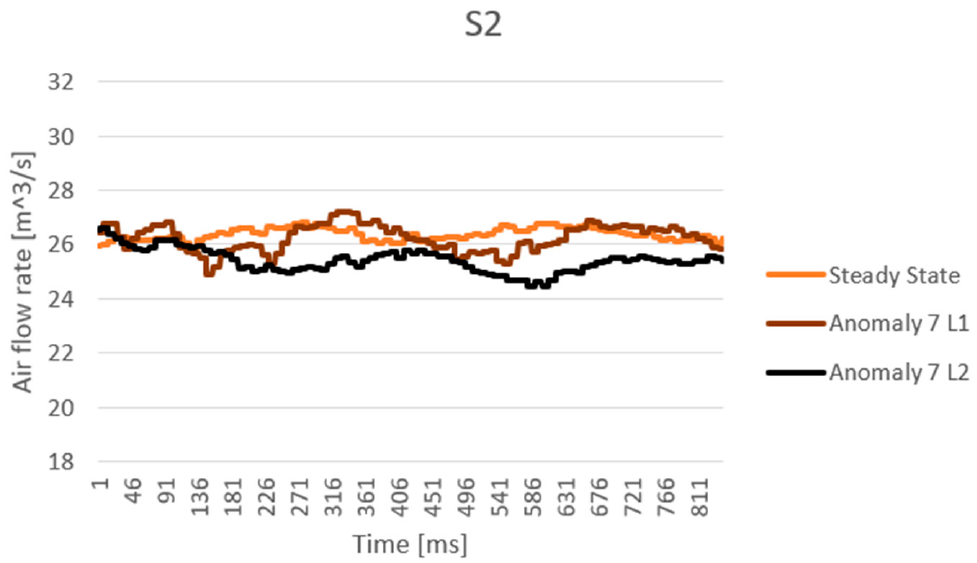
Figure 17. Inlet air flow rate of steady state, anomaly 7 level 1 and 2 samples.